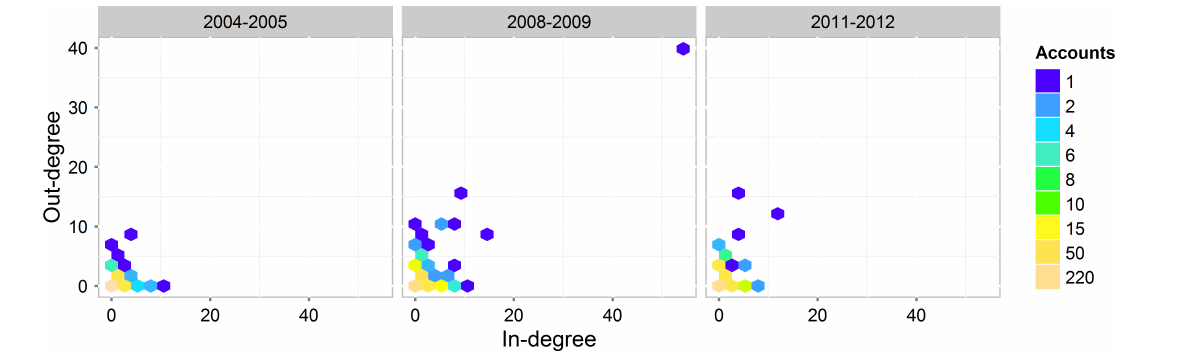
Fig. 5 . Number of accounts with illustrated combinations of incoming (in-degree) and outgoing (out-degree) relationships for the CT lease trade market in 2004-05, 2008-09 and